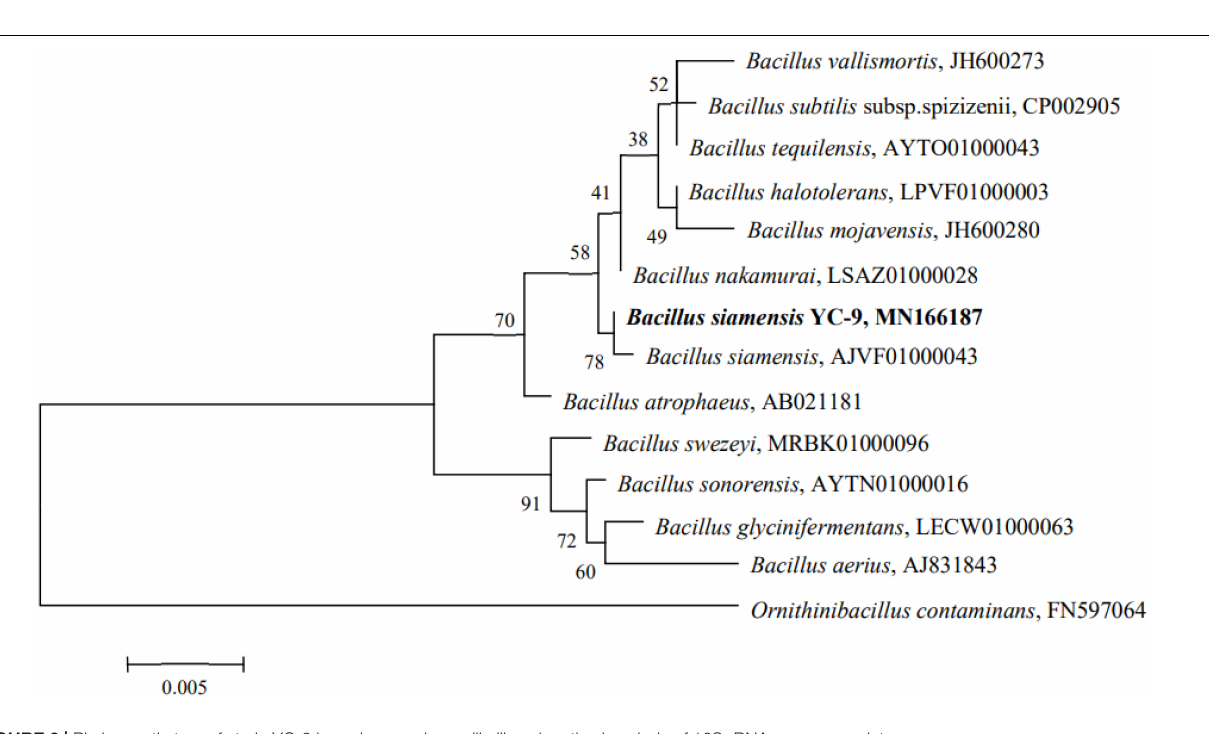
Frontiers in Microbiology |